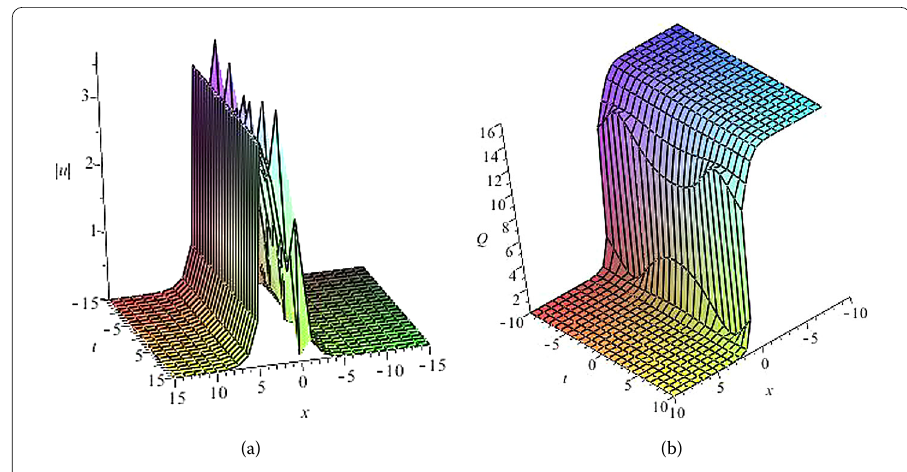
Figure 2 The plots of expression (15) with special parameters: k 1 = –1, k 2 = 3, p 1 = 2, p 2 = 4, y =